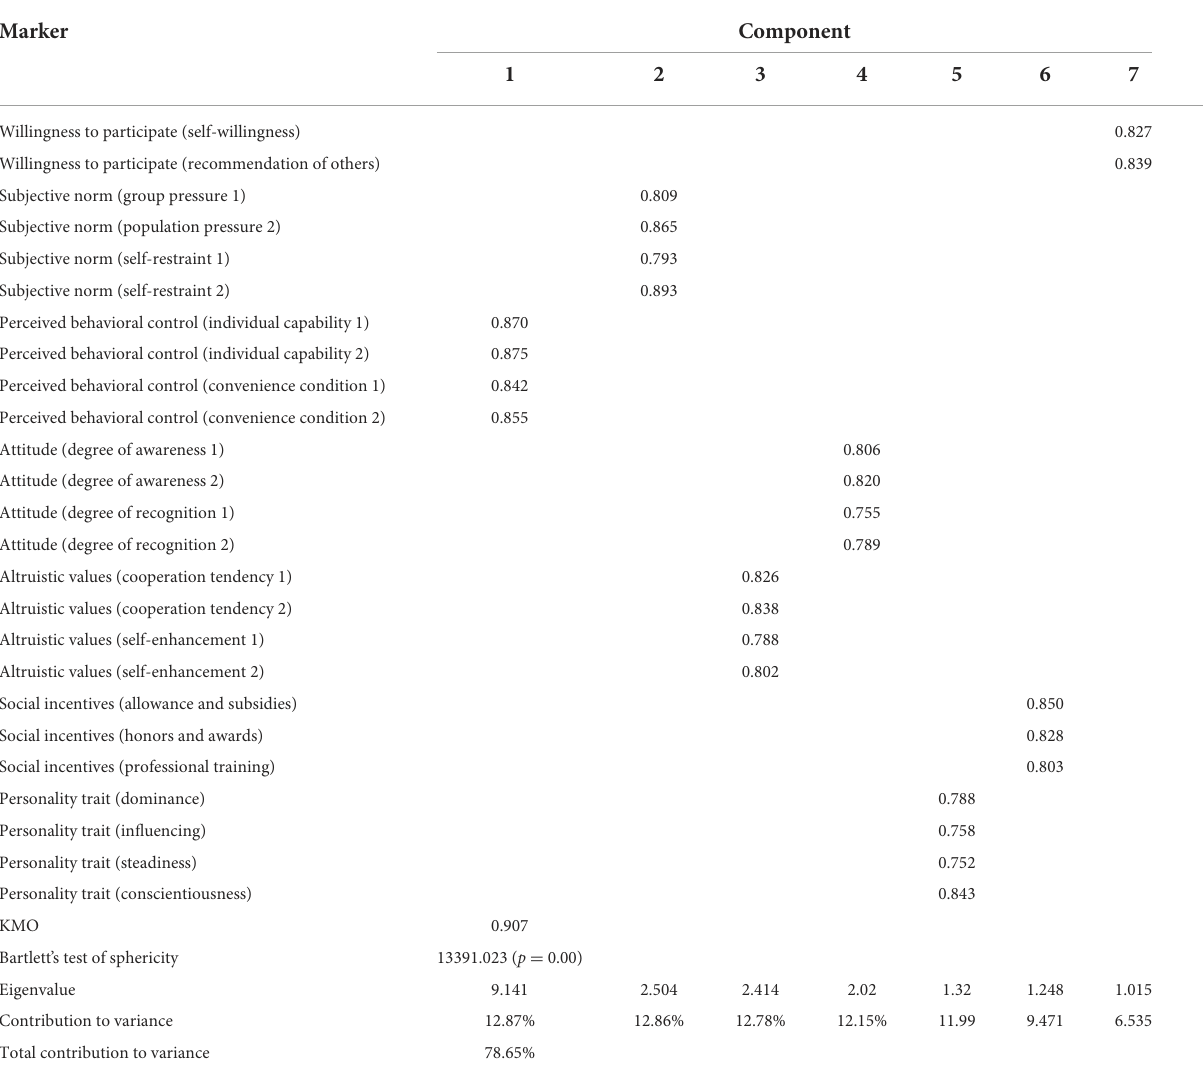
TABLE 3 Exploratory factor analysis